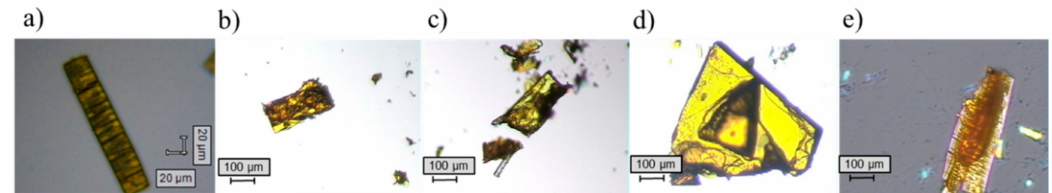
Figure 2. Micrographs of cocrystals obtained with a Nikon Eclipse 50iPOL microscope with the charge-coupled device (CCD) camera. ( a ) XN, ( b ) XN − NIC, ( c ) XN − GA, ( d ) XN − AC, and ( e ) XN −